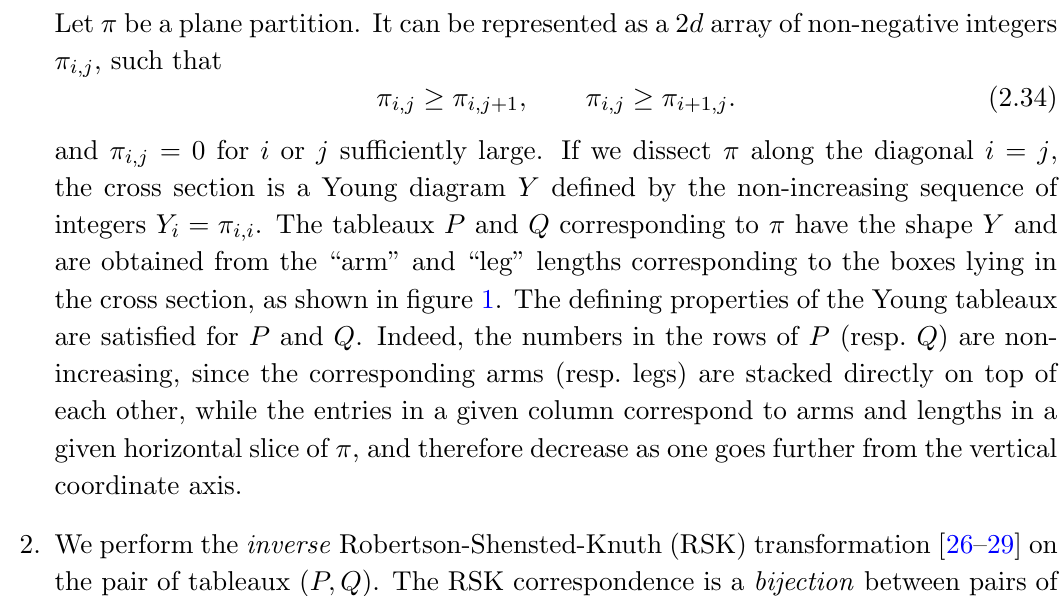
Figure 1 . A plane partition, which can be represented by an array (cid:25) i;j = cross section inside (cid:25) is shown in pale blue, it de(cid:12)nes a Young diagram Y = . The arm (resp. leg) lengths corresponding to the boxes on the cross section are shown in red (resp. blue).